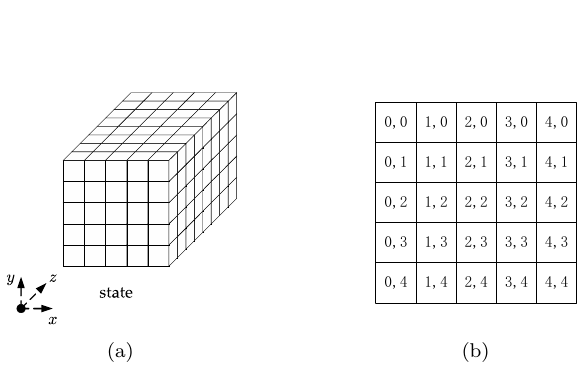
Figure 1: (a) The Keccak State [BDPA], (b) State A in